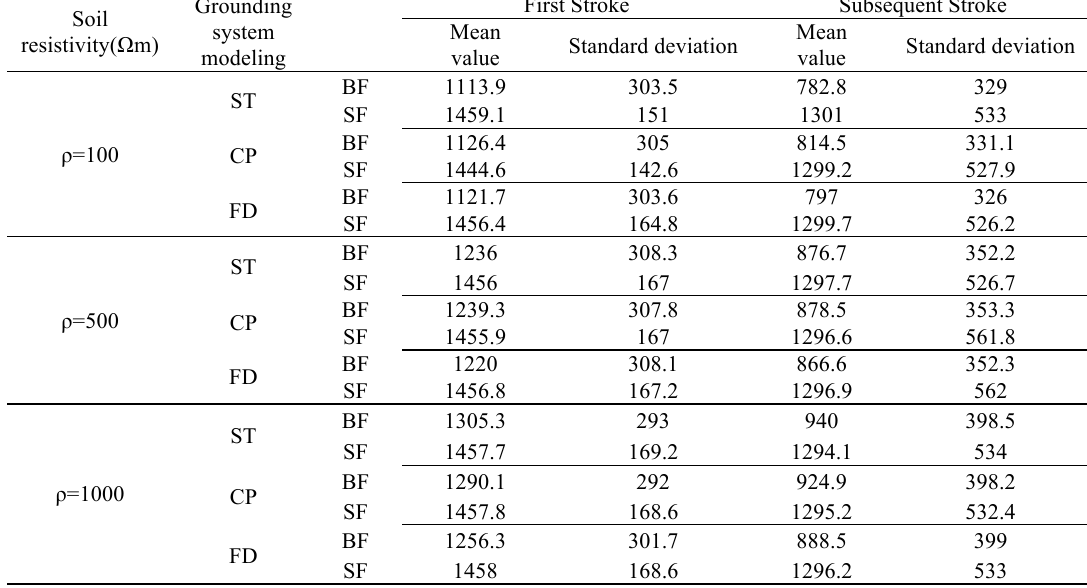
Table 8: Lightning overvoltage distribution (kV) for Different Modelling of Grid-shape Grounding